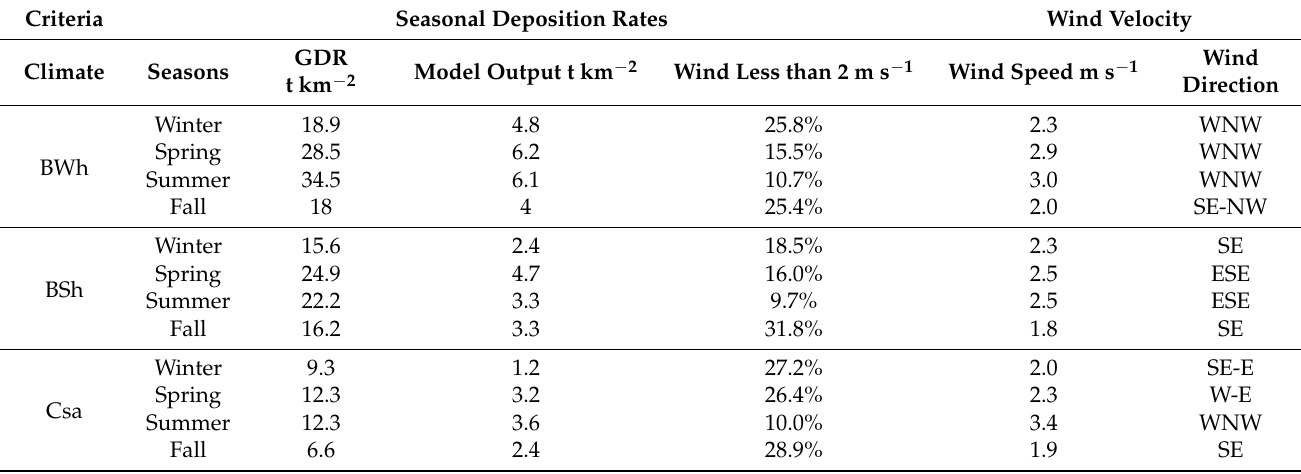
Table 4. Classification of the average seasonal deposition rates on the basis of wind patterns.